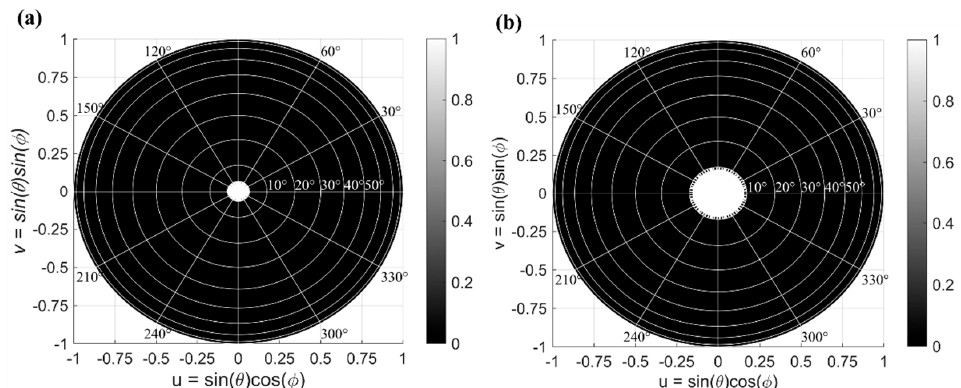
Figure 7. Steering range of the circular array with radially arranged nano-antennas for two design configurations: ( a ) 110 antenna elements with N = 10, M = 11, R 0 = 75 μ m, and dr = 10 μ m and ( b ) 870 antenna elements with N = 30, M = 29, R 0 = 96 μ m, and dr = 11 μ m. The white area represents the steering range.